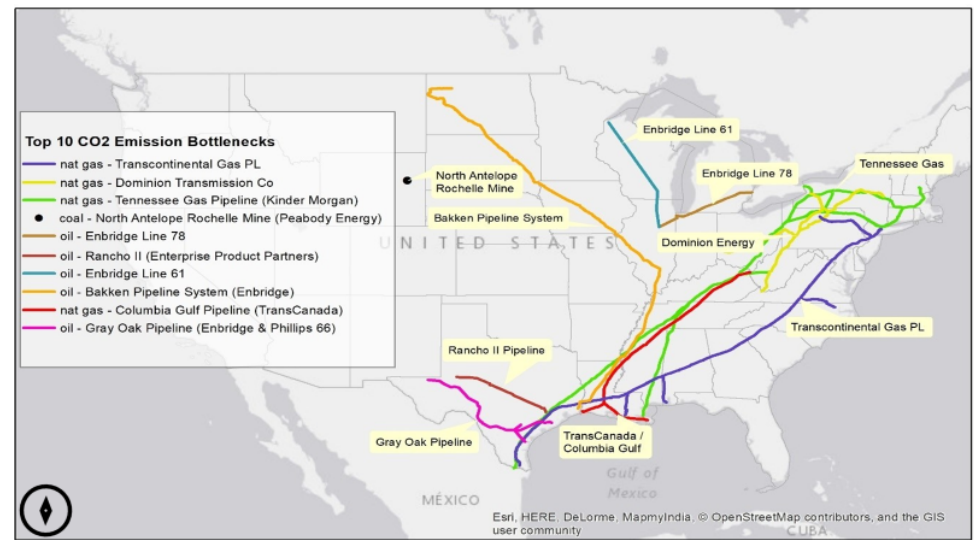
Figure 21. Overall Top 10 CO 2 Emission Bottlenecks Across All Fossil-Fuel Industries.